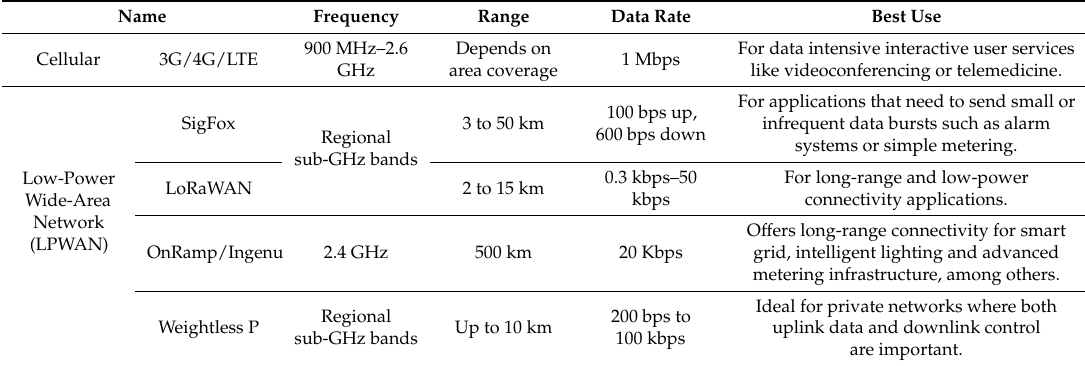
Table 1. Review of IoT